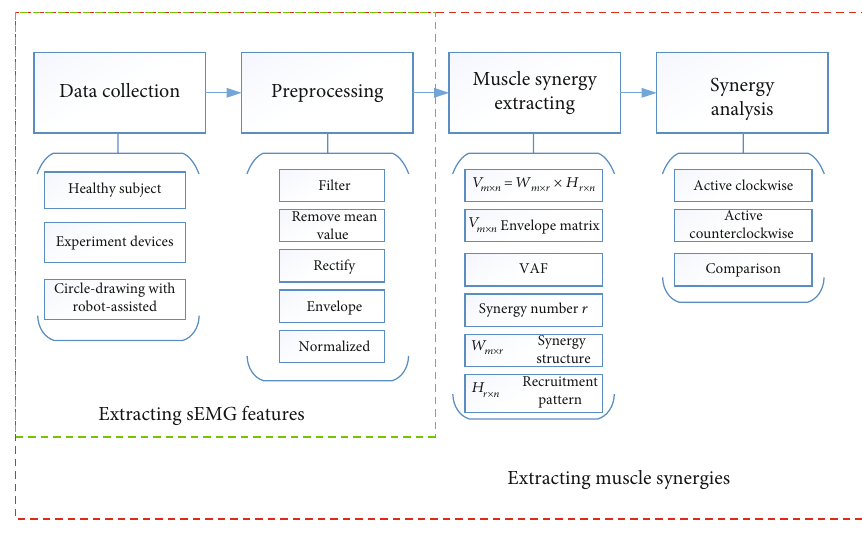
Figure 2: The illustration of sEMG data preprocessing and muscle synergy